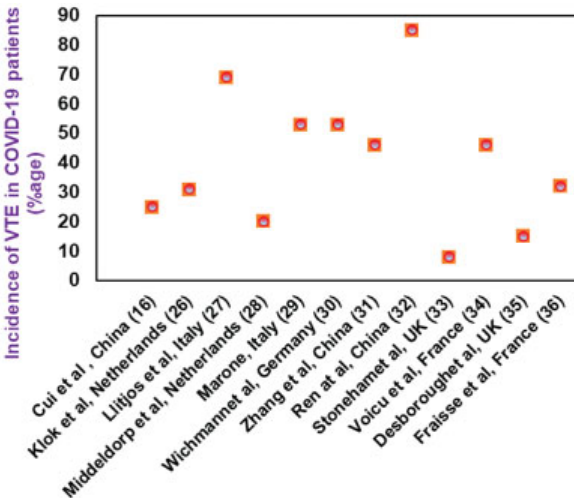
TH Open Vol. 6 No. 1/2022 © 2022. The